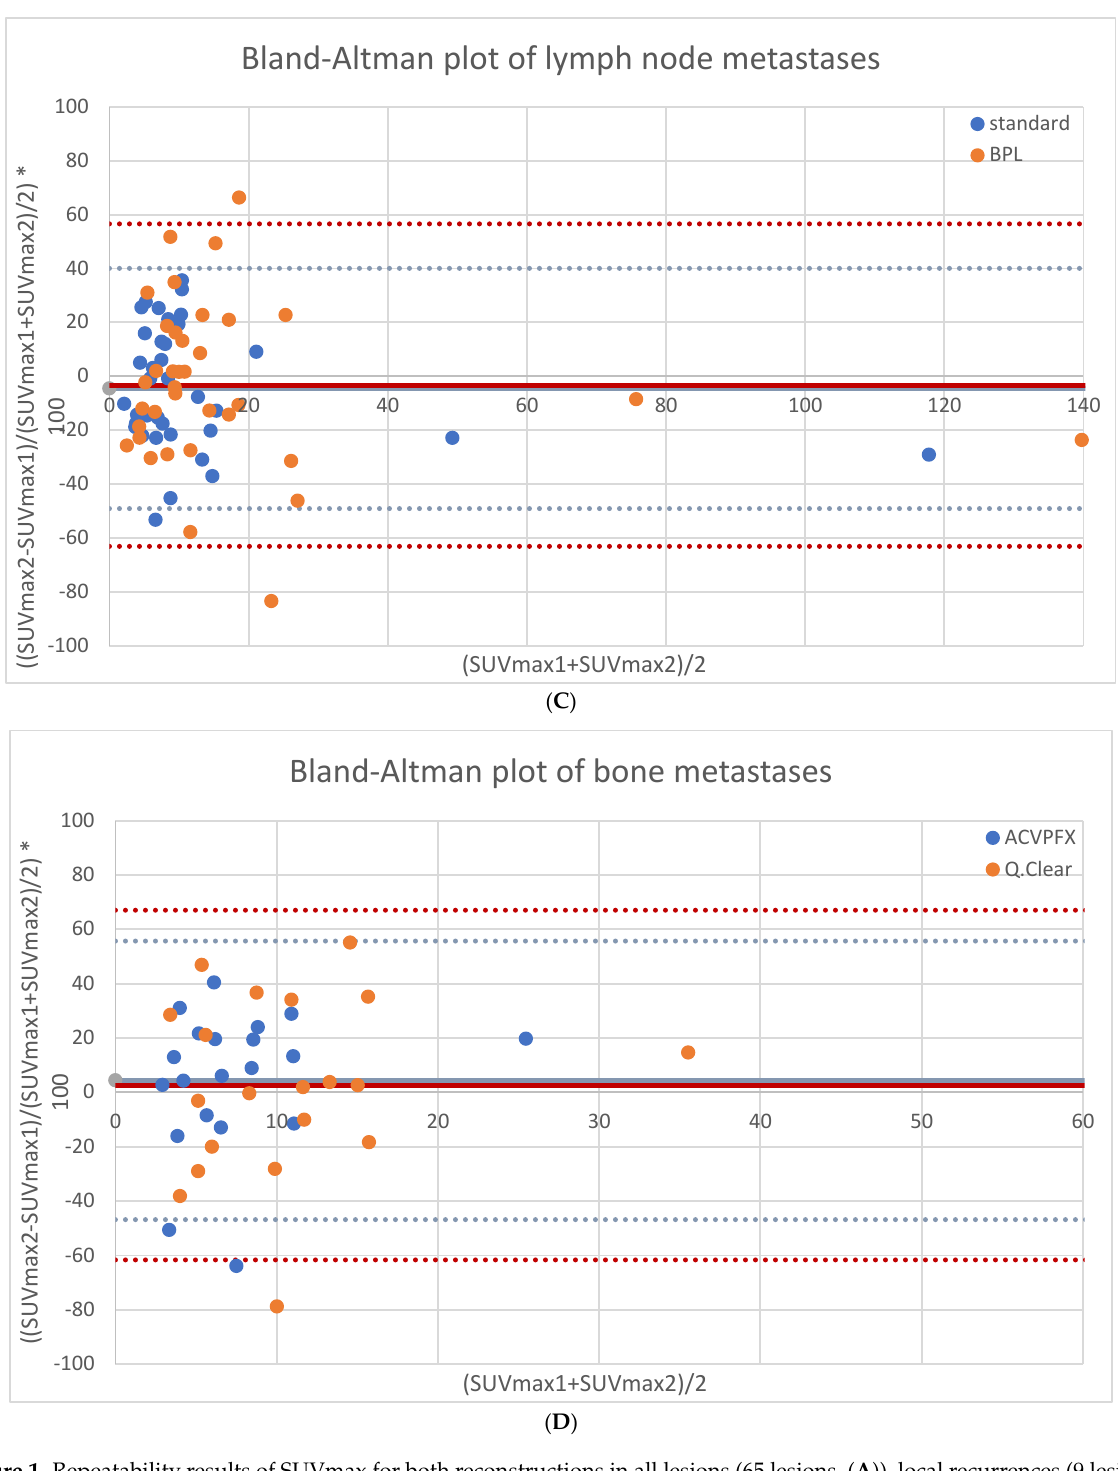
Figure 1. Repeatability results of SUVmax for both reconstructions in all lesions (65 lesions, ( A )), local recurrences (9 lesions, ( B )), lymph node metastases (36 lesions, ( C )) and bone metastases (20 lesions, ( D )). Tumor SUVmax repeatability was dependent on lesion area, with smaller lesions exhibiting poorer repeatability on both standard OSEM and BPL reconstructions (F-test, p < 0.0001). See Figure 2A,B.